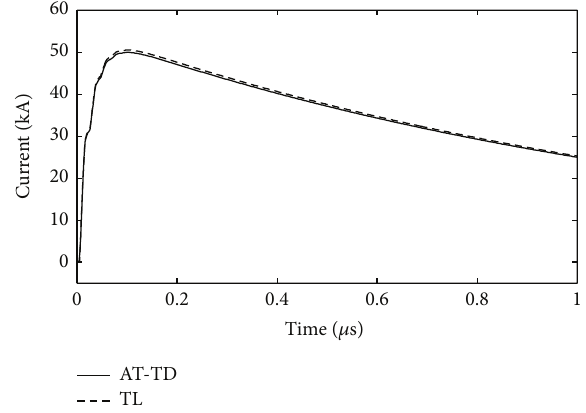
Figure 7: Transient current at the centre of the electrode: 𝐿 = 1 m, 𝜎 = 10 mS/m, and 0.1/1 𝜇 s